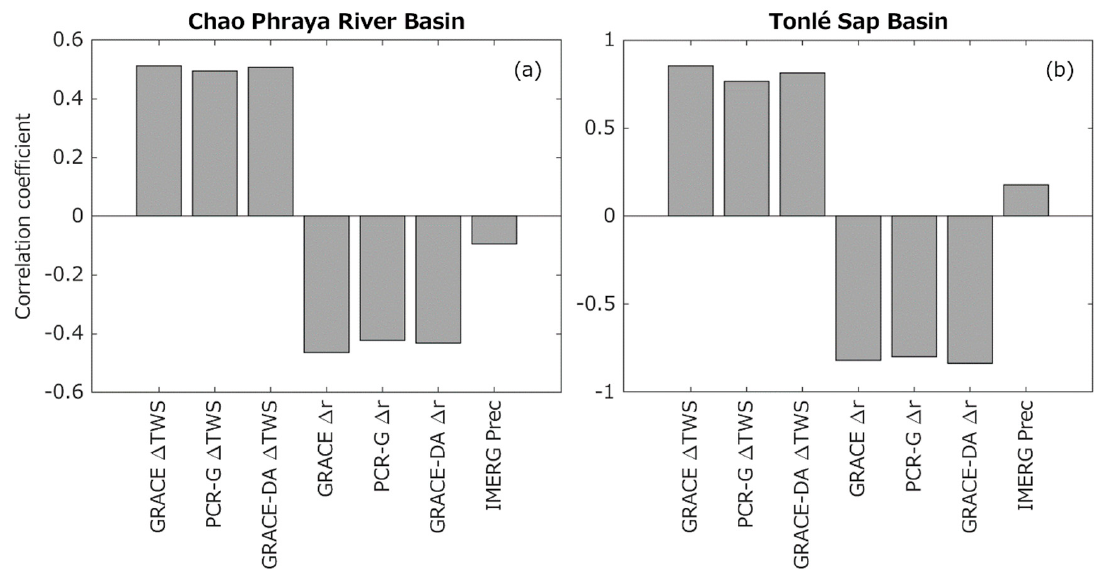
Figure 7. Correlation coefficients between the MODIS-derived surface water extent and different datasets; the ∆ TWS (GRACE, PCR-GLOBWB, and GRACE DA); the ∆ r (GRACE, PCR-GLOBWB, and GRACE DA); and precipitation (IMERG) in the Chao Phraya River (left; a ) and Tonlé Sap Basins (right; b ).